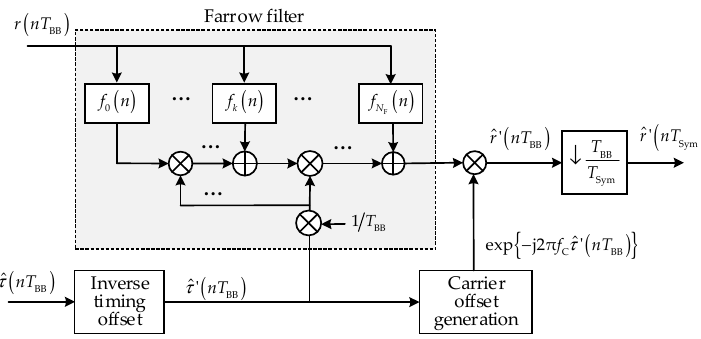
Figure 3. The timing offset compensation in the baseband.